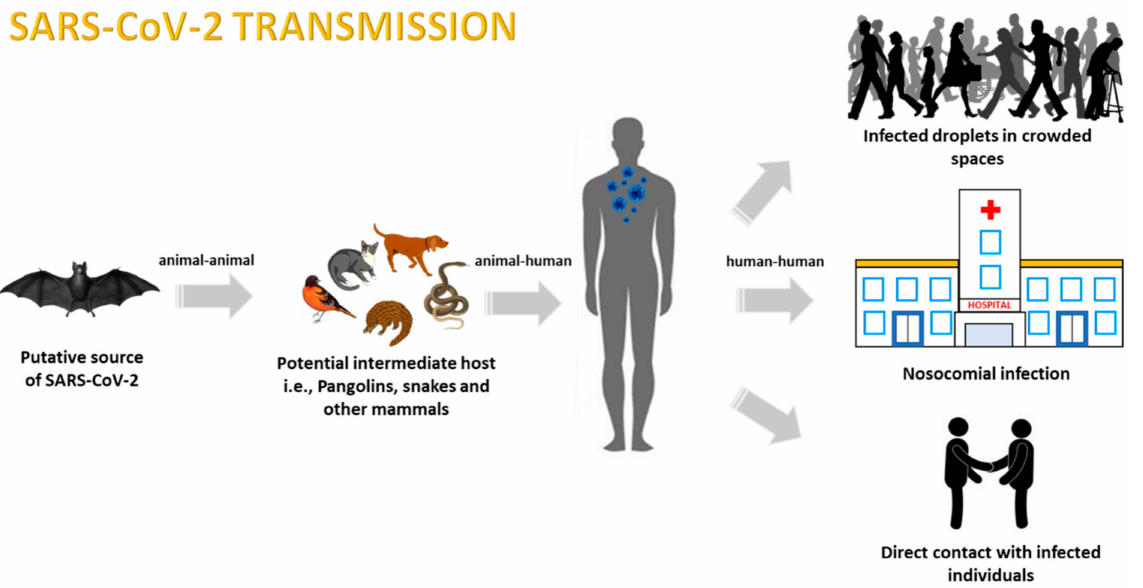
Figure 1. Representation of the zoonotic COVID-19 modes of